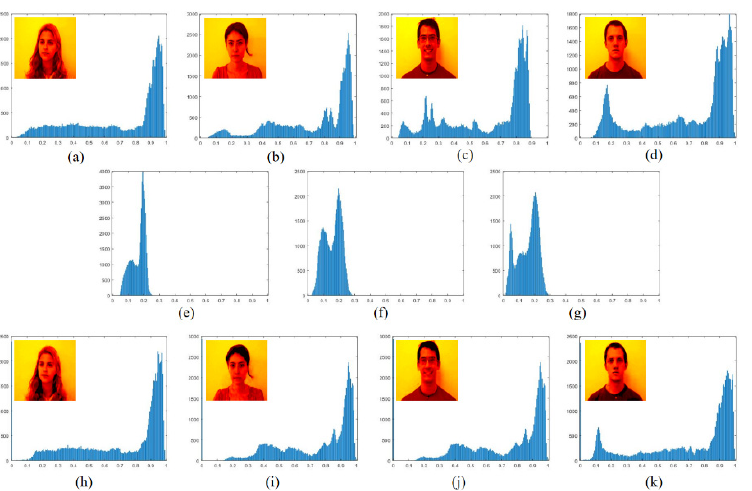
Figure 14. ( a – d ) Histograms of 4 plaintext images. ( e ) Superimposed light intensity histogram after encoding the first two images. ( f ) Superimposed light intensity histogram after encoding of the last two images. ( g ) Histogram of the final ciphertext image. ( h – k ) Histograms of the decrypted image.